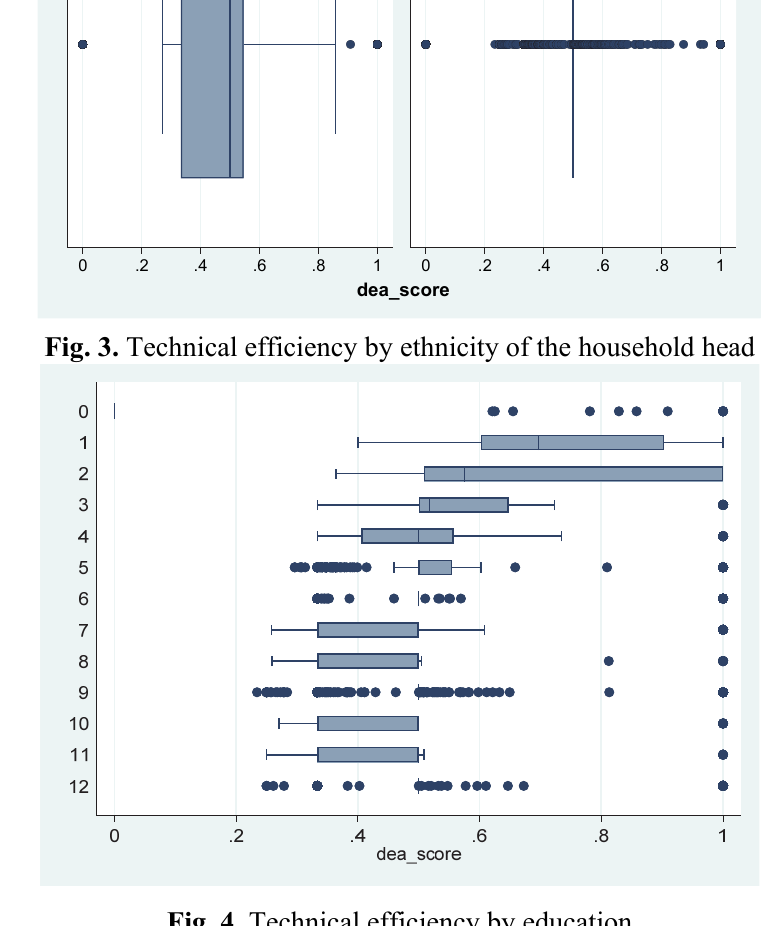
Fig. 4. Technical efficiency by